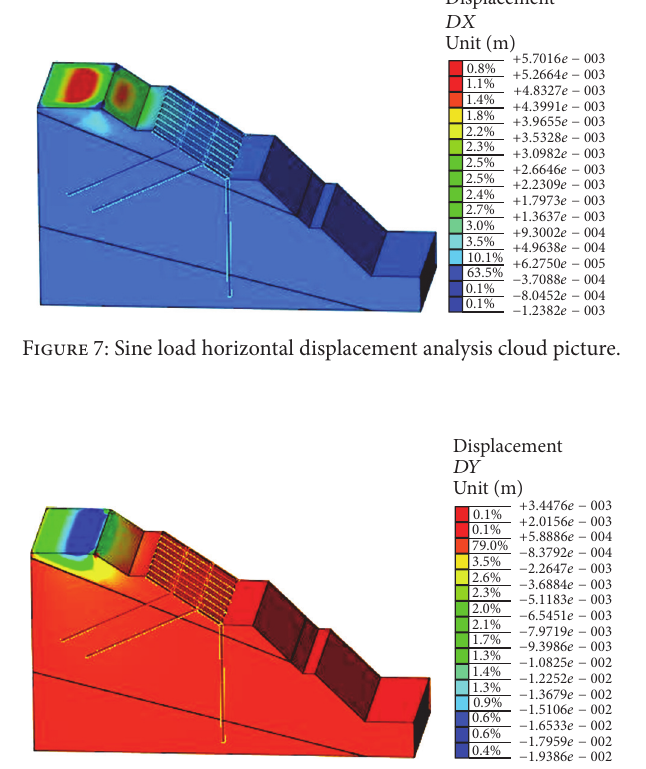
Figure 8: Sine load vertical displacement analysis cloud picture.